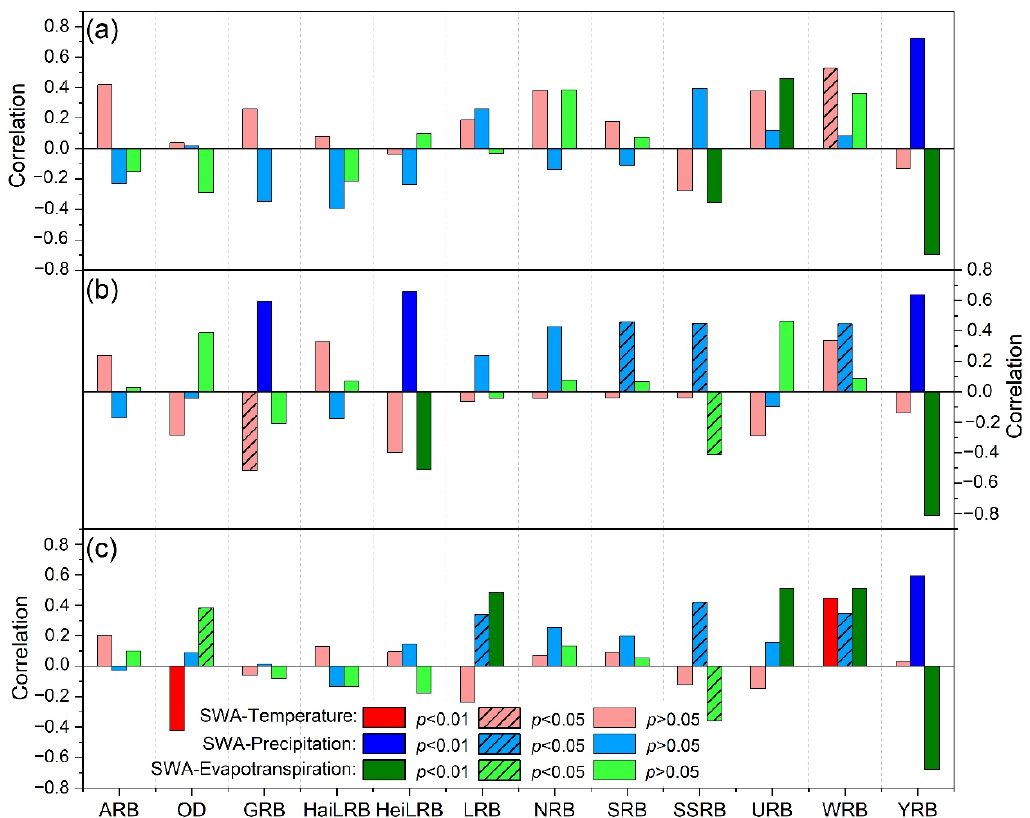
Figure 10. Correlations between PSWA and temperature, precipitation, and evapotranspiration in different periods: ( a ) the correlation between PSWA and three climate factors for 1988–1999, ( b ) for